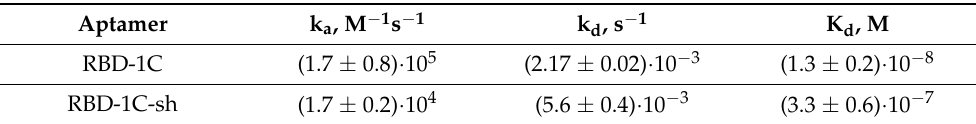
Table 1. The parameters of the complexes of RBD of S-protein with aptamer RBD-1C and its shortened version, RBD-1C-sh. Kinetic constants of association (k a ) and dissociation (k d ) as well as equilibrium dissociation constants (K d ) are provided .